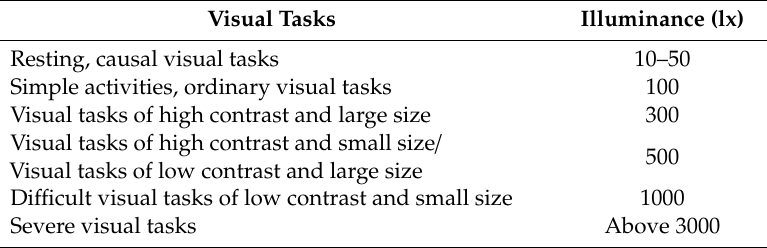
Table 3. Illuminance threshold values of